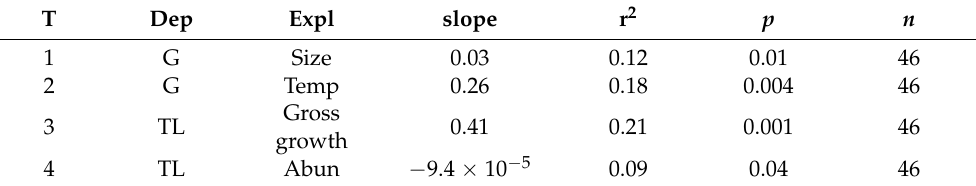
Table 4. Statistical data from linear models. T = test number. Dep = dependent variables: G = grazing rate (d − 1 ); TL = total loss rate (d − 1 ). Expl = explanatory variables: Size = average cell diameter ( µ m); Temp = temperature ( ◦ C); Gross growth = gross growth rate (d − 1 ); Abun = phytoplankton cell abundance (mL − 1 ). Slope = slope of regression line; r 2 = statistical measure of fit; p = p -value of significance; n = number of